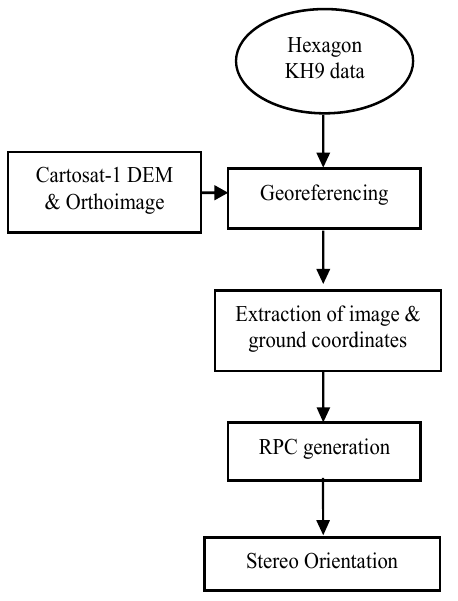
Figure 6. H exagon image with water bodies shown in red colour (digitized from Hexagon KH9 data of 1973) and blue polygons (new waterbodies digitized from Cartosat-